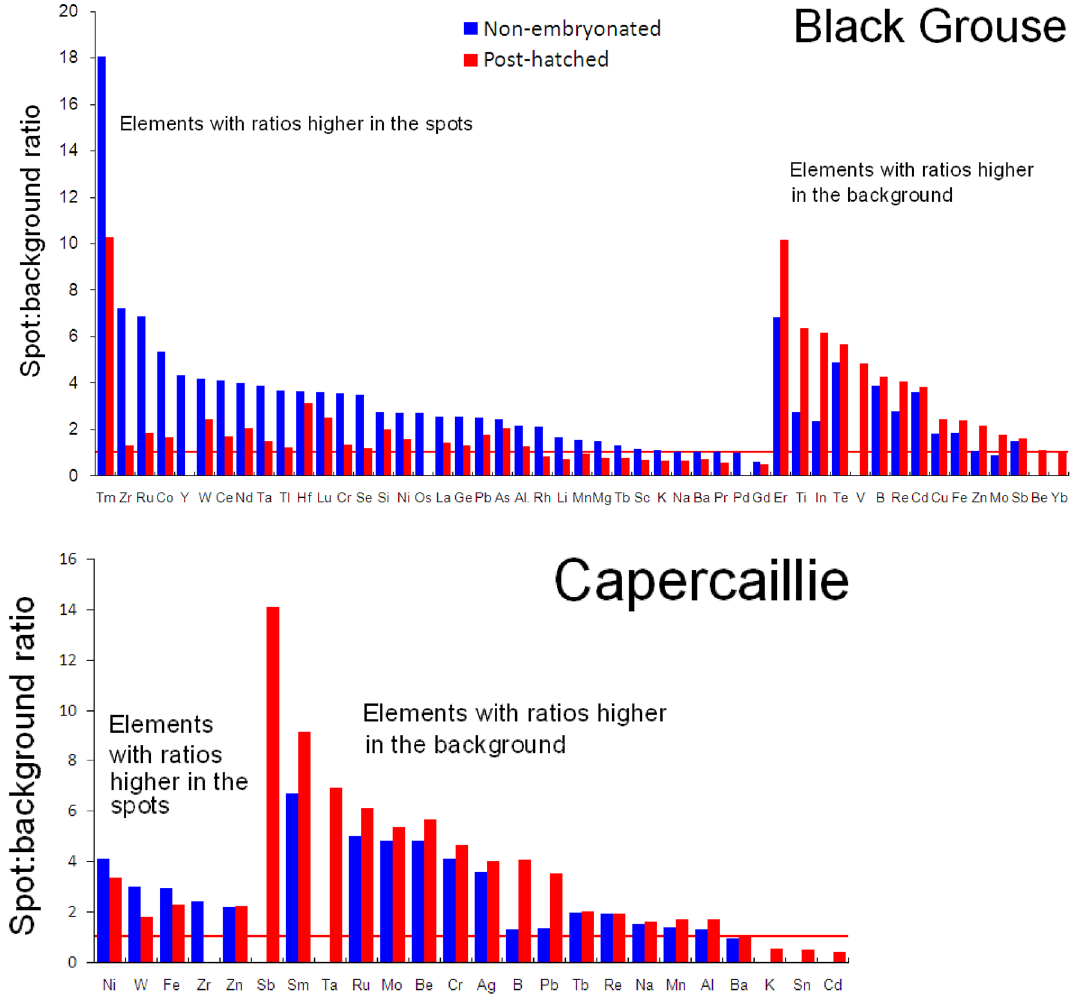
Figure 2. Ratios of elemental concentrations (based on pooled data for all the eggs—see Table S2 and Table S3) between the pigment spot and background colour regions of eggshells at two extremes of avian embryonic development, defined as non-embryonated eggs (maternal level) and post-hatched (resorbed) eggshells in cryptic eggs of Black Grouse Tetrao tetrix and Capercaillie Tetrao urogallus . The variation in elemental concentrations in the spot-background eggshell regions within the same eggs (for corresponding pairs of measurements) is illustrated in Fig. S1. Note : The red line (ratio = 1) signifies no difference in eggshell elemental concentration between the pigment spot and background colour region; the bars with ratios < 1 indicate higher elemental concentrations in the background colour